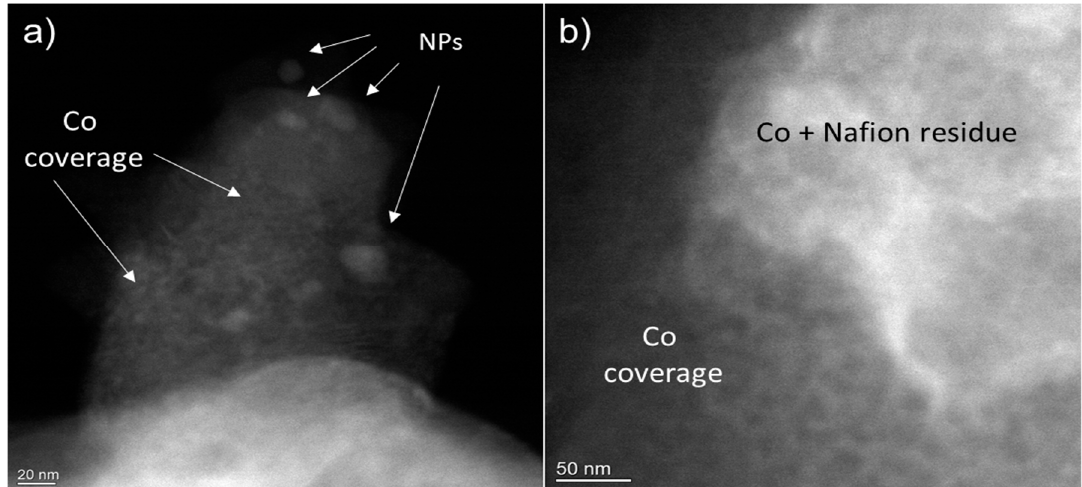
Figure 5. HAADF images of typical char grains after Co electrodeposition. Larger NPs in ( a ) are ZnS. Co is uniformly covering the grains surfaces with a network of islands. Whiter areas in ( b ) Contain fluorine due to the presence of residues of Nafion used to treat the sample. (see EDX analysis in Figure S9).